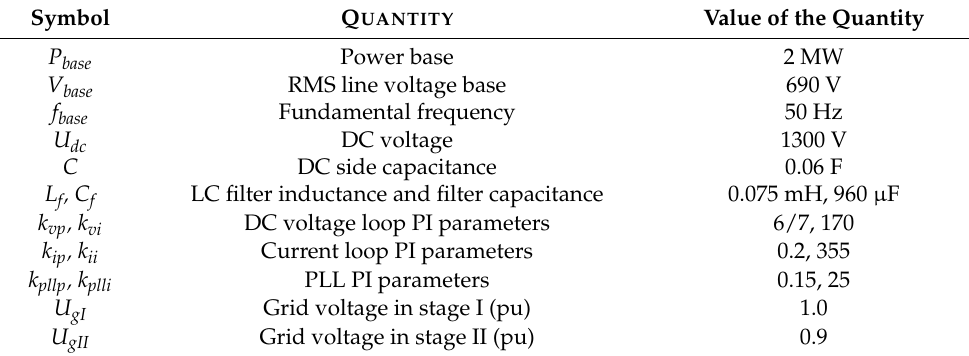
Table 1. Simulation and Experimental